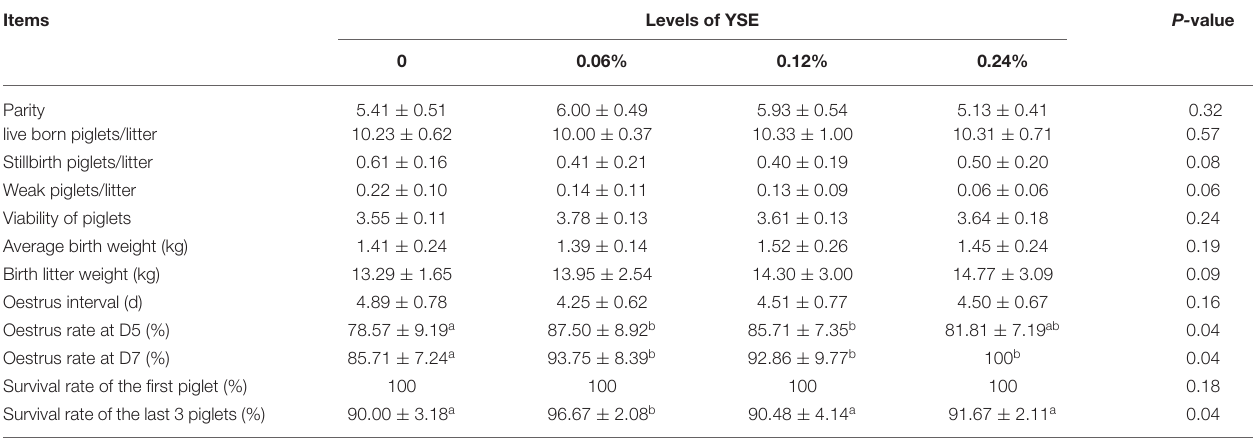
TABLE 2 | Effect of dietary YSE to sow reproduction performance.